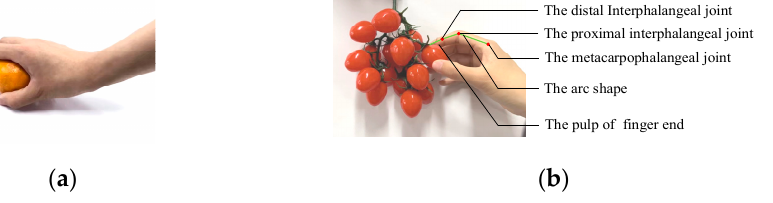
Figure 1. Comparison of fruit grasping in different sizes: ( a ) grasping of larger fruit; ( b ) grasping of small